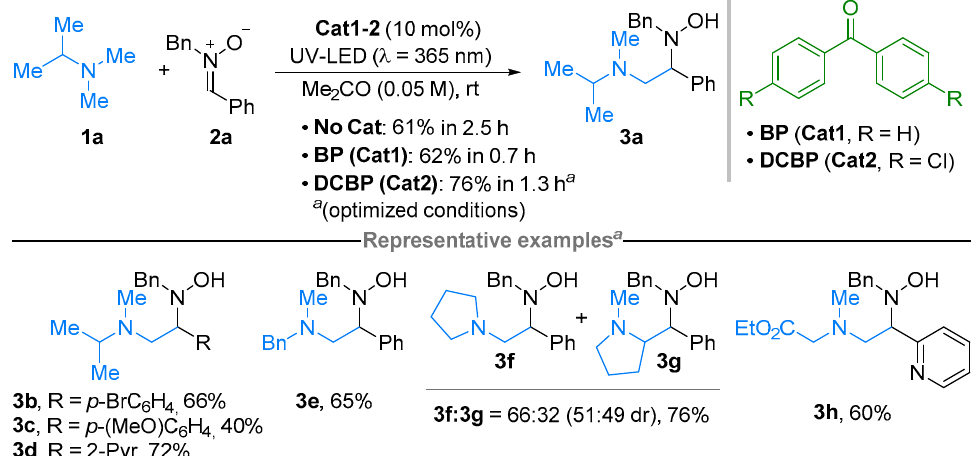
Scheme 1. Photoredox-catalyzed reaction of aliphatic α -aminoalkyl derivatives with